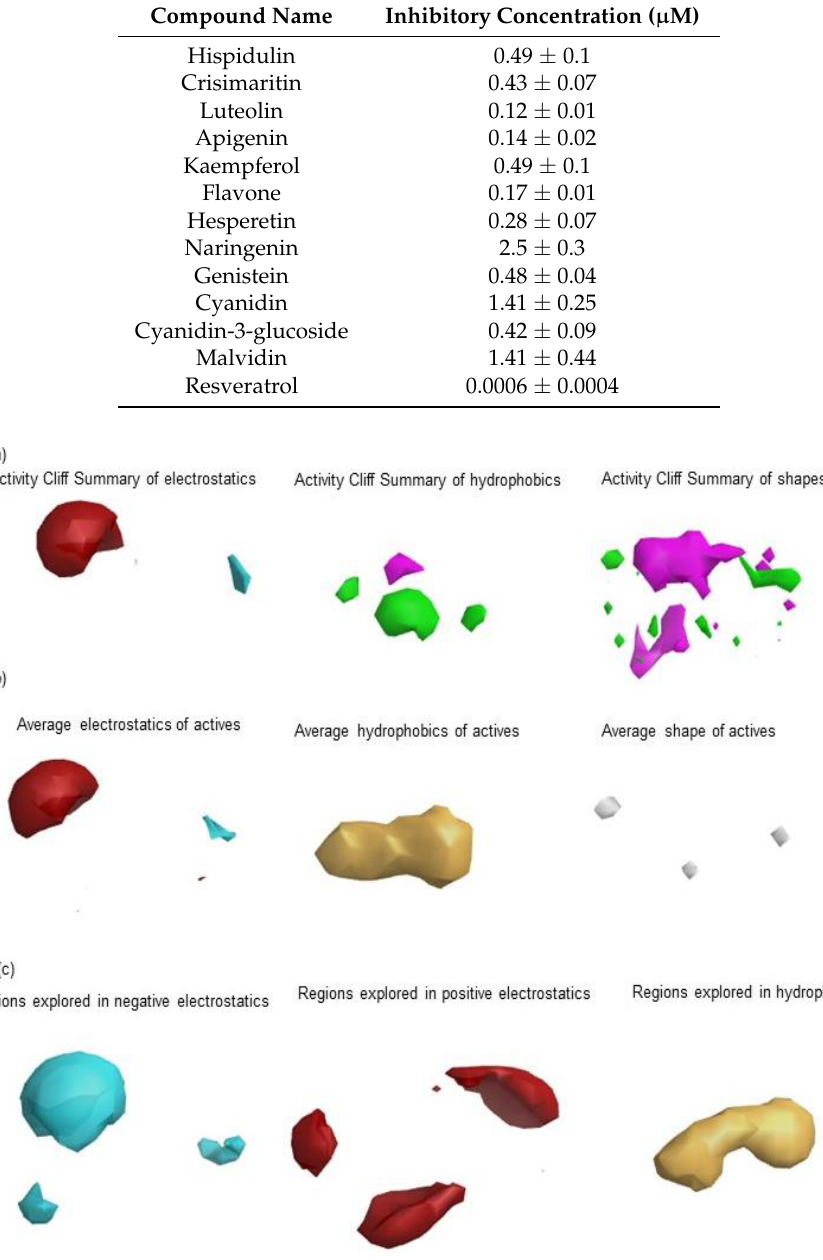
Table 1. Natural products proven to inhibit dipeptidyl peptidase-4 enzyme activity. Table 1 . Natural products proven to inhibit dipeptidyl peptidase-4 enzyme activity.